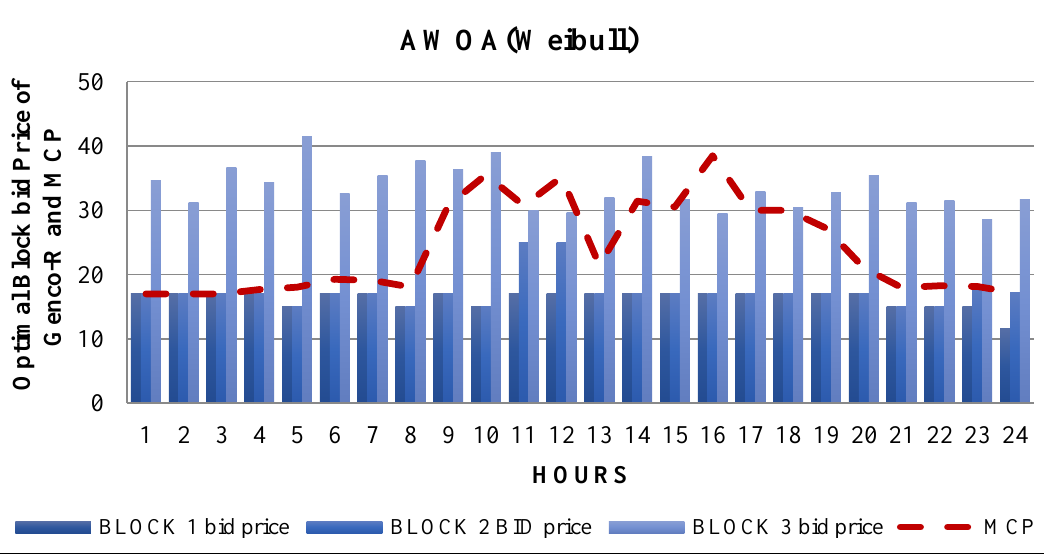
Figure 17. AWOA (Weibull Distribution) Block Bid Price and MCP.